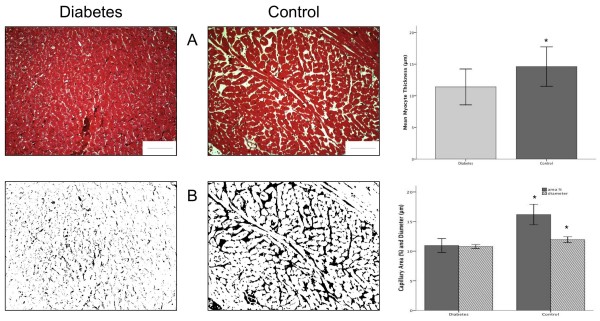
Histological characteristics and analysis of the myocardium in the diabetic and control rats after 20 weeks. Top panel (A), Masson's trichrome staining showed no evidence of myocardial fibrosis in both groups. Cardiomyocytes were smaller in the diabetic animals (upper right). Lower panel (B), the histological photographs (A) were subsequently converted to 8-bit grey scale images (not shown) and an appropriate threshold was chosen in order to visualize the capillaries only (black and white images, B). The percentage capillary area and capillary diameters were lower in the diabetic rats compared to controls (lower right). Magnification at 400× (A and B), scale bar is 100 μm, *P < 0.05.